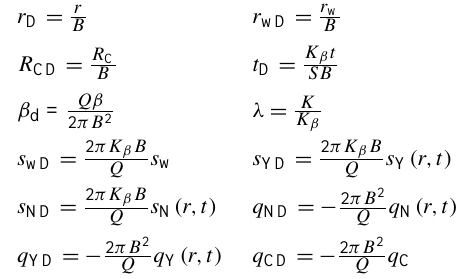
Table 1. Dimensionless variables used in this